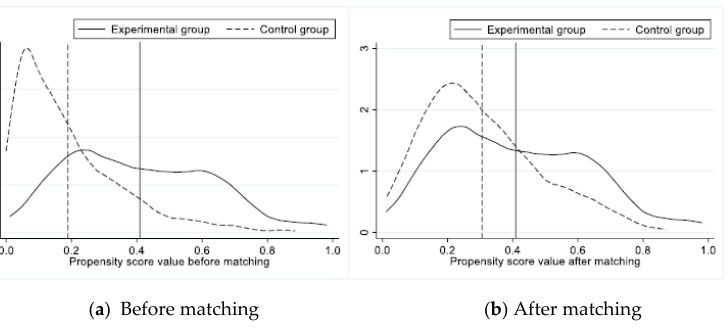
Figure 4. Kernel function plot before and after sample matching. ( a ) Before matching: ( b ) After matching. In addition, a further balance test of the sample, as shown in Table 4, indicated that none of the covariates was significantly and systematically different after the matching. Table 4. Balance test results.